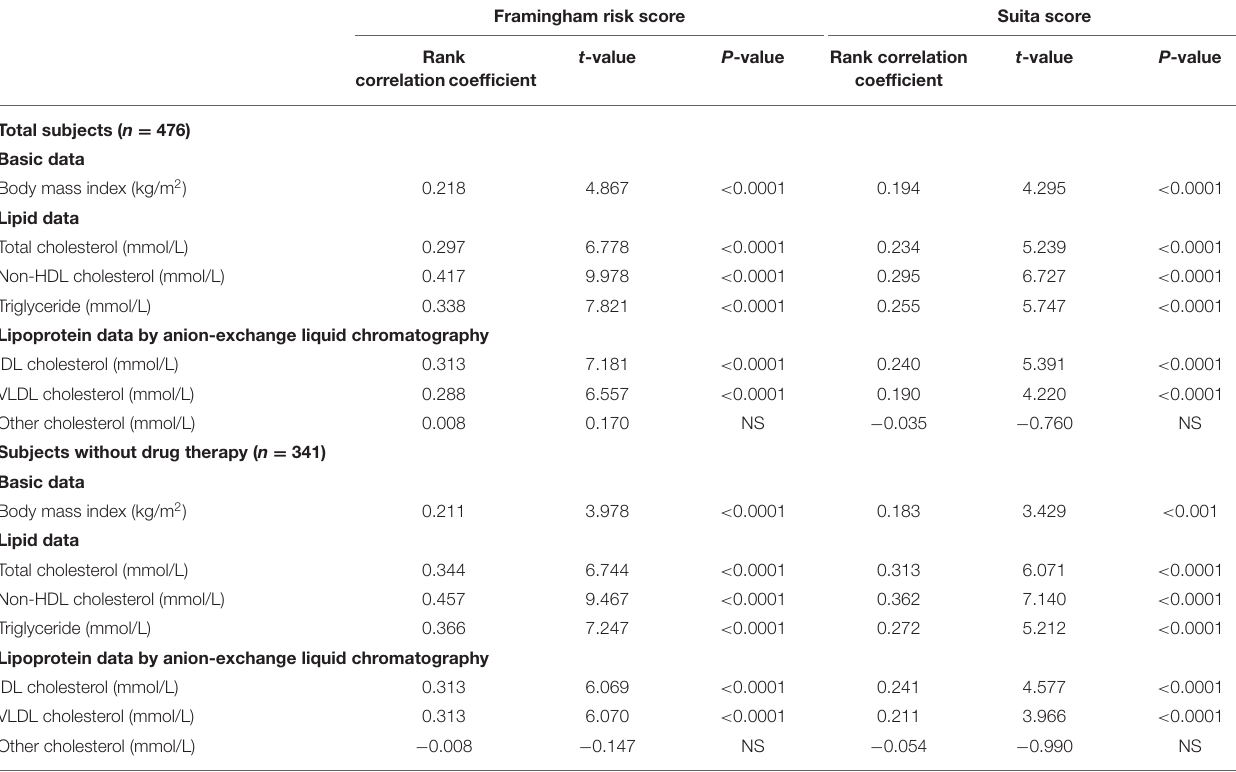
TABLE 2 | Simple correlations of body mass index and serum lipids to Framingham risk score and Suita